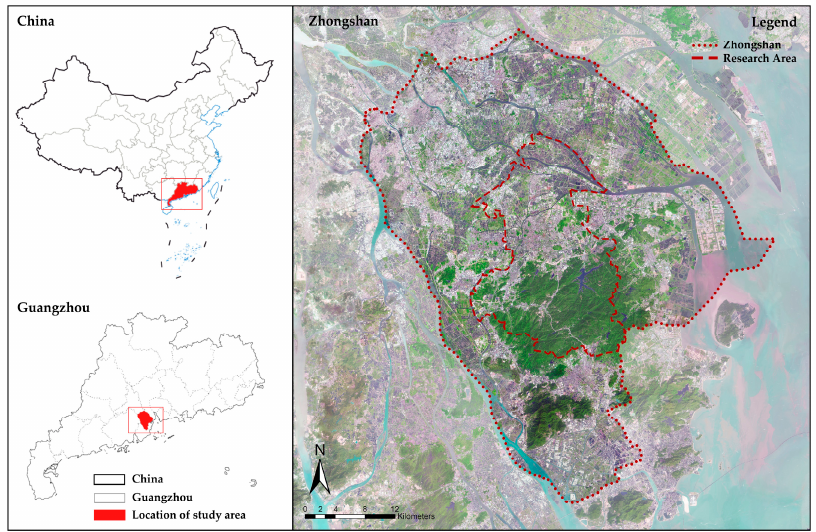
Figure 2. Location of Zhongshan City and its central city, Guangdong Province, China.